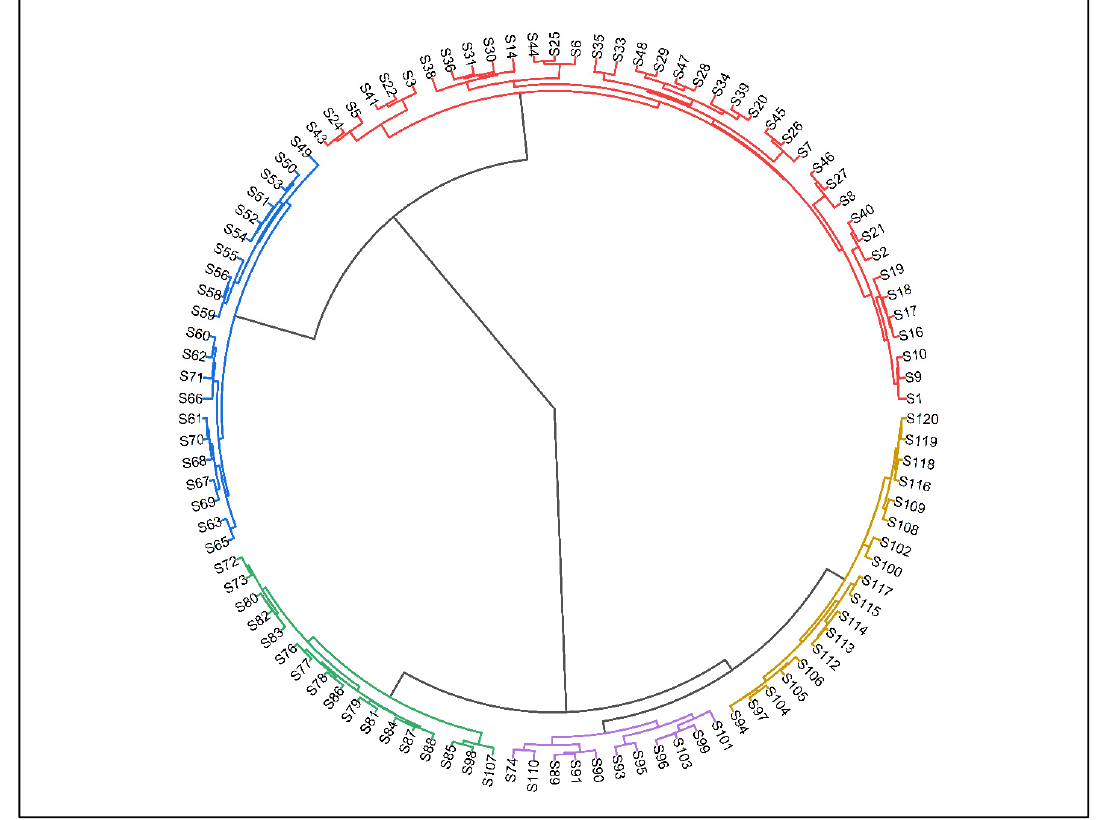
Figure 5. An agglomerative hierarchical clustering dendrogram of the 120 sampling sites, illustrating the five woody plant communities in the semi-arid lowland Punjab, Pakistan. Color Coding: Red = 1. EDM: Eucalyptus - Dalbergia - Morus community; Yellow = 2.PBM: Populus - Bombax - Morus community; Purple = 3. ZTZ: Ziziphus - Tamarix - Ziziphus community; Green = 4. PAP: Prosopis - Acacia - Prosopis community; Blue = 5. BCR: Broussonetia - Conocarpus - Ricinus community.